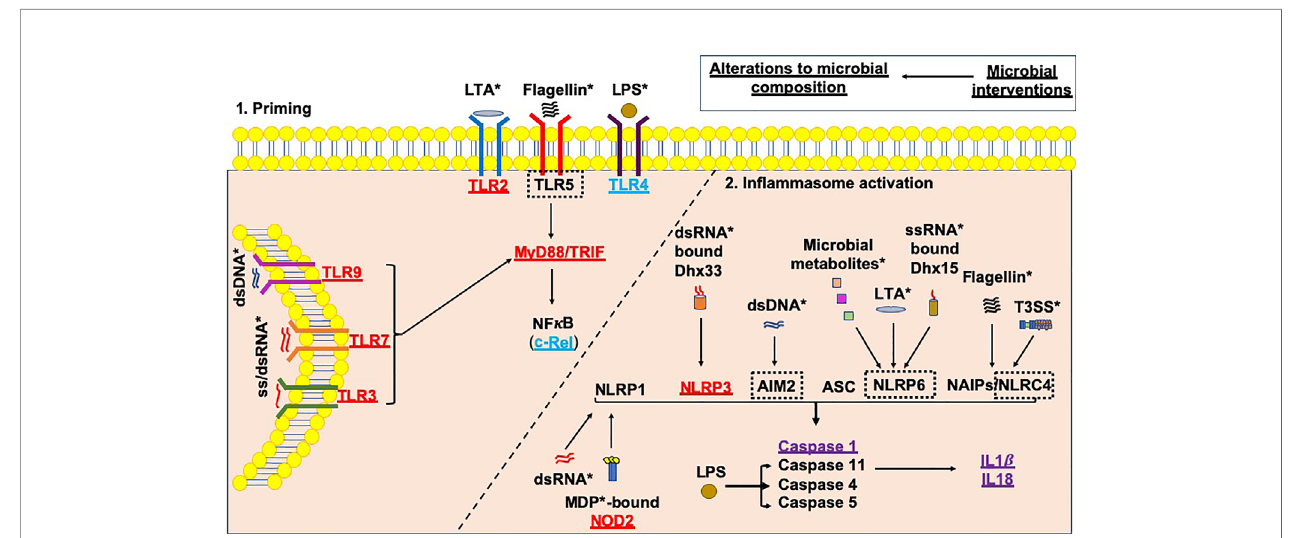
FIGURE 3 | Microbial in fl uences on in fl ammasome priming and activation in type 1 diabetes. Microbial interventions e.g. fecal microbiota transplants, antibiotic, probiotic and prebiotic usage can all in fl uence the microbial composition, subsequently altering the availability of microbial ligands involved in both the priming, and canonical and non-canonical activation of in fl ammasomes (as shown by *). Studies of single PRR or in fl ammasome ( nlrp3 ) gene-de fi cient mice have shown that these proteins would be needed to promote the development of T1D (shown in red); however, Tlr4-de fi cient and c-Rel-de fi cient NOD mice (c-Rel is a subunit of the NF к B protein) promote tolerance and limit the development of T1D (shown in blue). In addition, some gene-de fi cient mice showed no signi fi cant effect on mediating susceptibility to T1D (shown in purple). A number of planned studies are currently underway using a number of gene-de fi cient mice to assess their ability to alter susceptibility to T1D development, as shown by the black dotted boxes. Paradoxically, the gene-de fi cient mice are also likely to have altered microbial composition, contributing to the protection against/susceptibility to disease. Studies of these gene-de fi cient mice will need to evaluate the contribution of the gene independently from any alterations to the microbial